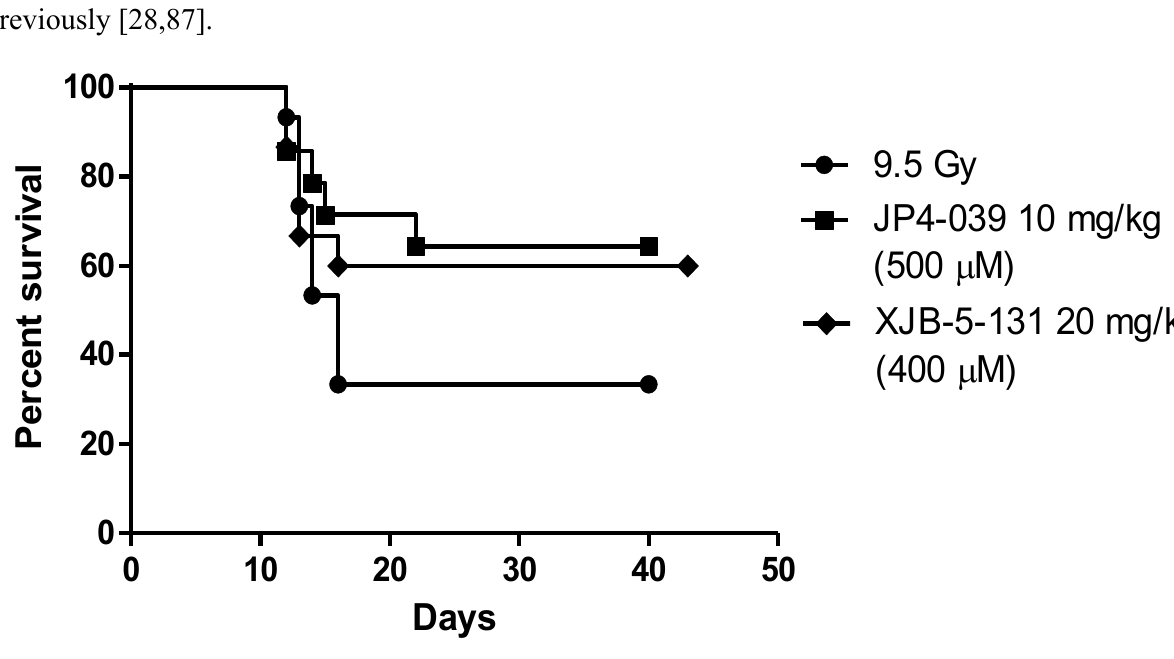
Figure 2. Effective radiation mitigation by two GS-nitroxide analogs (XJB-5-131 and JP4-039). Groups of 15 C57BL/6NHsd mice received total body irradiation, and then 24